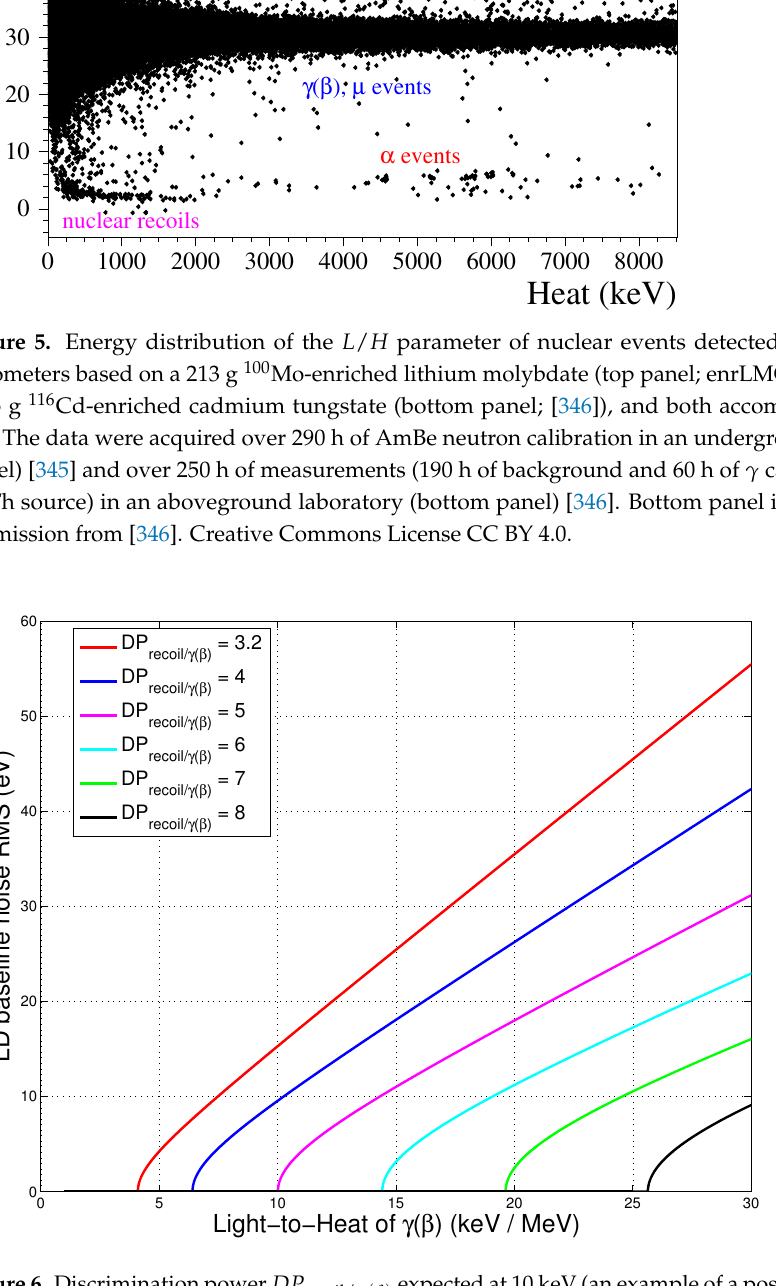
Figure 6. Discrimination power DP recoil/ γ ( β ) expected at 10 keV (an example of a possible dark matter search ROI). as a function of the LD noise resolution and the relative scintillation signal ( L / H γ ( β ) parameter) of a scintillating bolometer. The assumed quenching factor for nuclear recoils (0.1) and an average photon energy (2.95 eV) are taken as for calcium tungstate scintillating